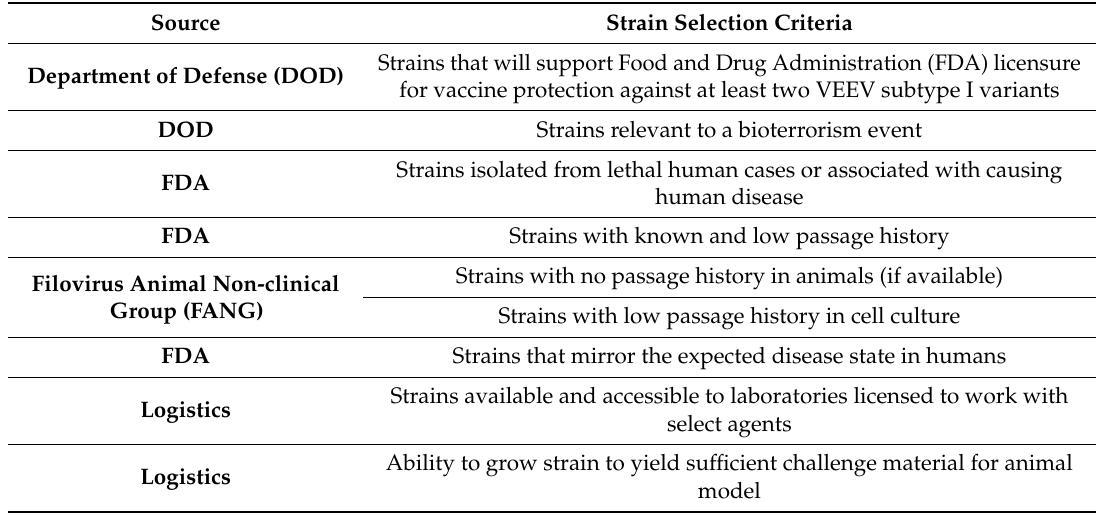
Table 1. Venezuelan equine encephalitis virus (VEEV) strain selection criteria for VEE vaccine animal model [7,8]. Source Strain Selection Criteria Strains that will support Food and Drug Administration (FDA) licensure Department of Defense (DOD) for vaccine protection against at least two VEEV subtype I variants DOD Strains relevant to a bioterrorism event Strains isolated from lethal human cases or associated with causing FDA human disease FDA Strains with known and low passage history Strains with no passage history in animals (if available) Filovirus Animal Non-clinical Group (FANG) Strains with low passage history in cell culture FDA Strains that mirror the expected disease state in humans Strains available and accessible to laboratories licensed to work with Logistics select agents Logistics